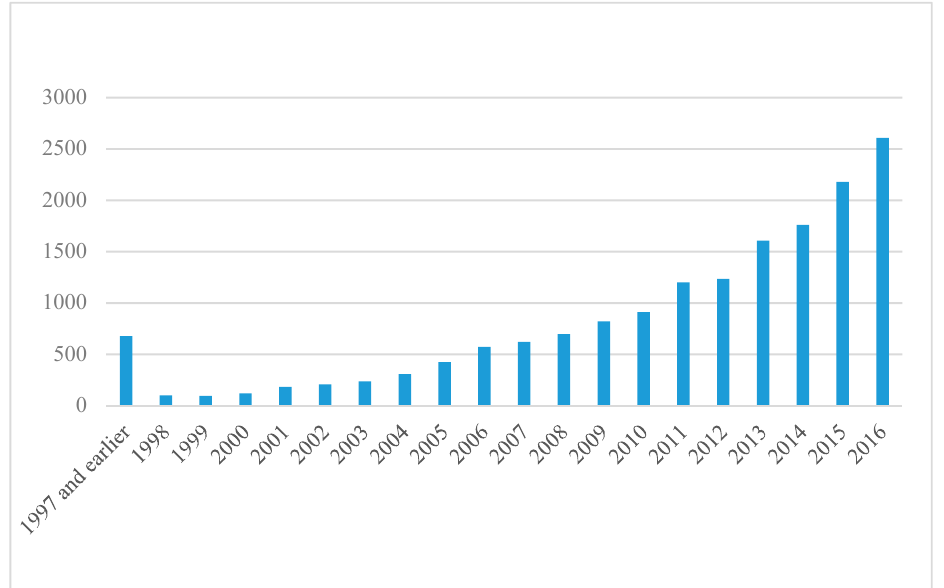
Figure 4. Number of published papers in the field of nanocoating and corrosion.